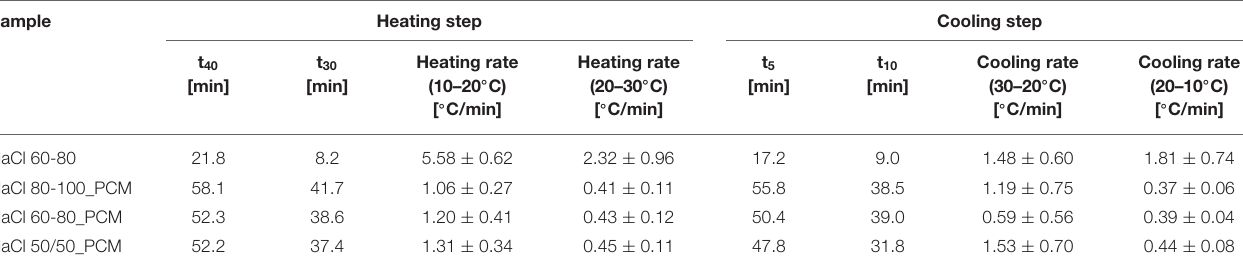
TABLE 5 | Results of the thermal imaging tests on the EPDM and TES-EPDM foams in the heating and cooling step.